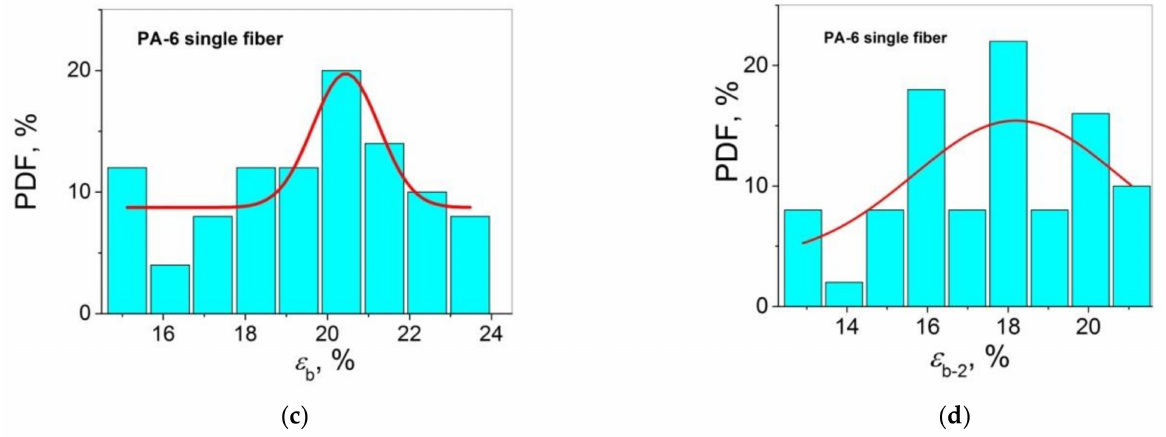
Figure 5. ( a ) Strains at break ε b and ε b-2 as functions of sample number n in an ascending order for PA 6 single fibers; ( b ) Weibull’s plots for the data presented in ( a ); PDF vs. ε b ( c ) and ε b-2 ( d ) for the data presented in ( a ); the bell curves are the Gaussian fitting results.